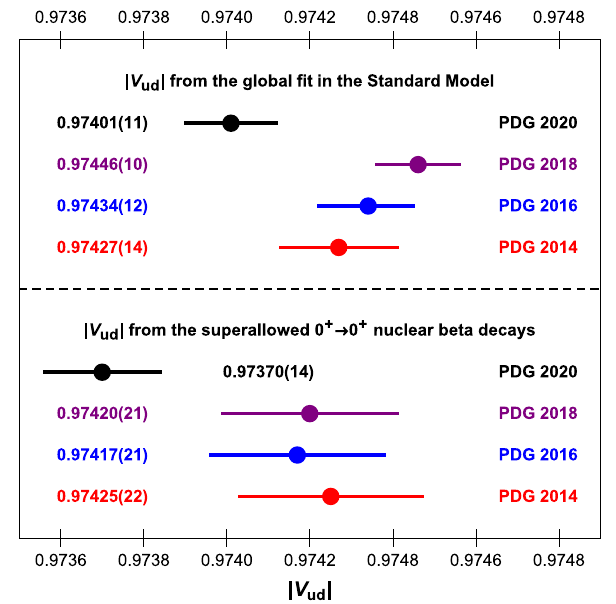
Fig. 1 The values of the CKM element | V ud | from Particle Data Group (PDG)